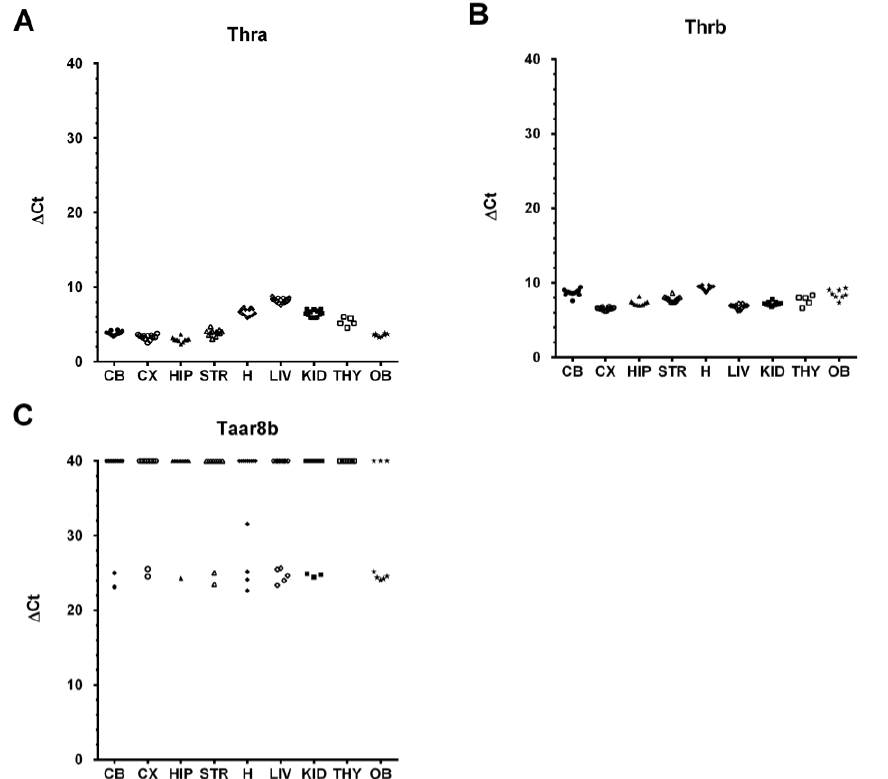
Figure 1. Normalized expression levels of the positive control genes Thra and Thrb and the target gene Taar8b . Normalization was performed by Δ C t -value calculation, i.e. , by subtracting the C t -value of the calibrator gene Gapdh from the C t -value of the positive control or target gene (Δ C t, ( Thra ) = C t ( Thra ) – C t ( Gapdh ); Δ C t ( Thrb ) = C t ( Thrb ) – C t ( Gapdh ); Δ C t, Taar8b = C t ( Taar8b ) – C t ( Gapdh )). The Δ C t -values of samples which yielded “undetermined” C t -values in PCR runs of 50 cycles for all technical replicates were artificially set to 40 and, thus, are visible above the group of samples with detectable C t -values ( C t < 50). In all other cases, Δ C t -values were calculated from mean C t -values of the technical replicates for which a C t -value was measured. If only one technical replicate yielded a C t -value smaller than 50, this C t -value was used for Δ C t -calculation. Positive control genes Thra and Thrb were not included in the analysis of three thyroid samples because of the limited amount of RNA. Graphs are depicted for the positive control genes Thra ( A ) and Thrb ( B ) and for the target gene Taar8b ( C ). Samples from male and female mice for each tissue type are collectively grouped. CB, cerebellum; CX, cortex; HIP, hippocampus; STR, striatum; H, heart; LIV, liver; KID, kidney; THY, thyroid; OB, olfactory bulb; C t , threshold cycle; Gapdh , glyceraldehyde-3-phosphate dehydrogenase; Thra , thyroid hormone receptor alpha; Thrb , thyroid hormone receptor beta; Taar8b , trace amine-associated receptor